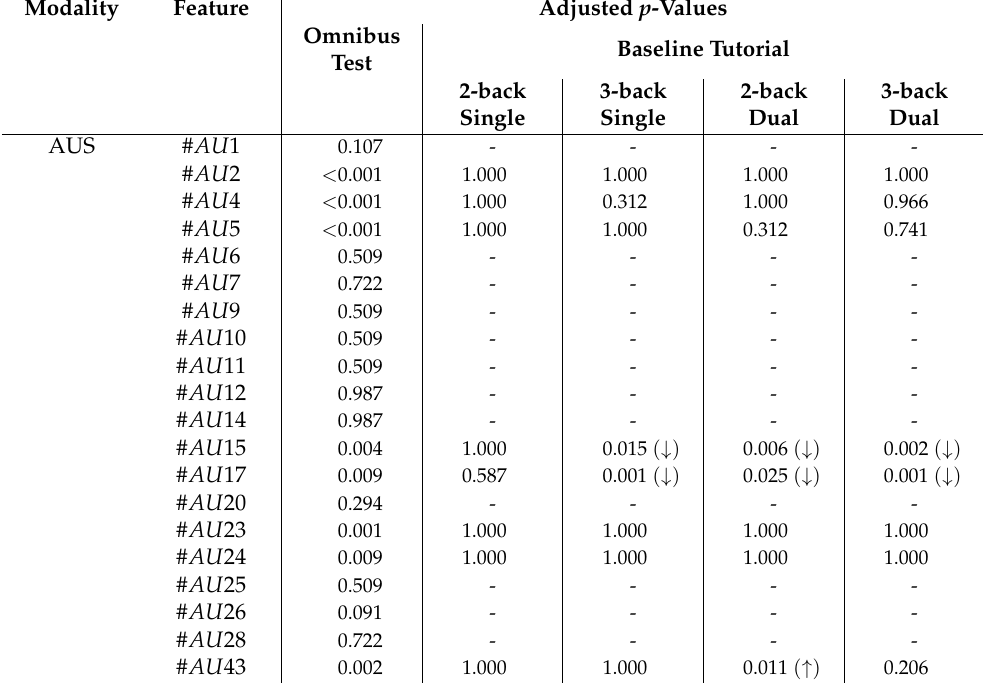
1,2,3 -drive test. Increase ( ∈ { }